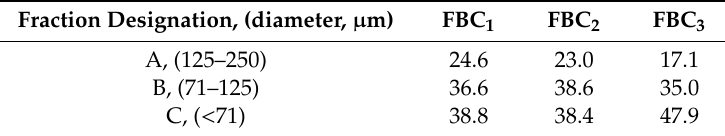
Table 2. Share of grain fractions in FBCs—sieve analysis results,